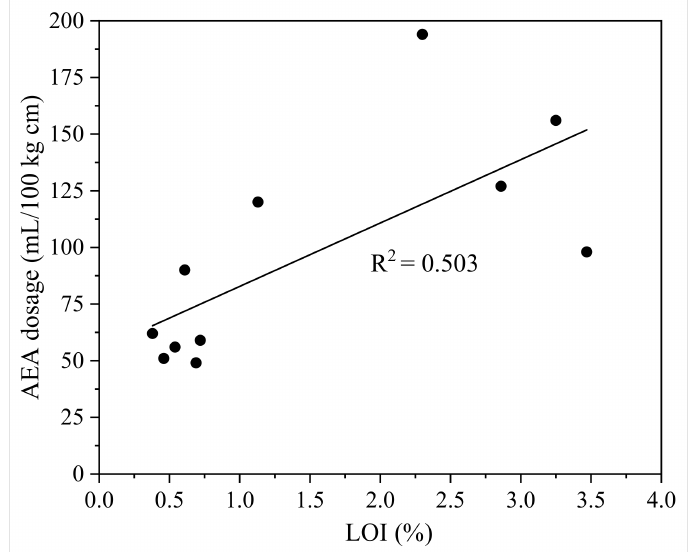
Figure 3. The correlation between the LOI of fly ash and the AEA dosage requirement.